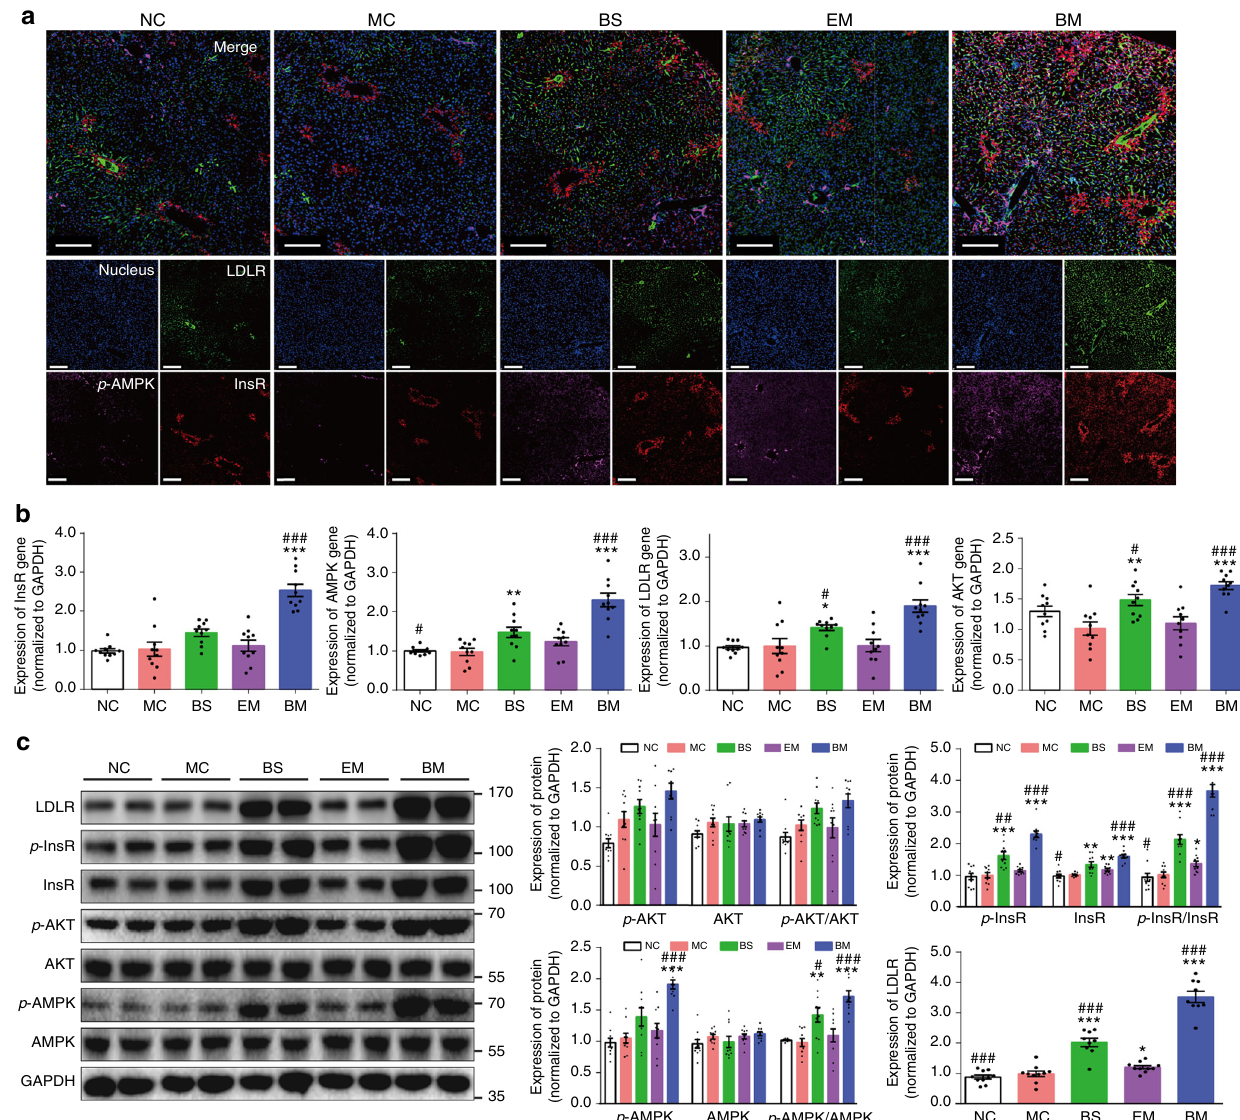
Fig. 5 In vivo pharmacodynamics. C57BL/6J mice were feed with HFD for 8 weeks, followed with randomly allocated into four groups: model control group (MC), BBR-S group (BS, 50 mg kg − 1 of BBR), empty micelle group (EM, same as BBR micelles) or BBR-CTA-Mic group (BM, 50 mg kg − 1 of BBR), accompanied with HFD for another 8 weeks by gavage. Untreated mice fed with standard rodent diet (NC) were used as control. a Representative photographs of p -AMPK (pink), InsR (red) and LDLR (green) protein expression in liver tissue of different group mice were visualized using C2t Nikon fl uorescent microscope (Morrell, USA) by probing with anti-InsR, LDLR and p -AMPK antibodies simultaneously. b The mRNA expression of AMPK , InsR , AKT , and LDLR genes was evaluated by RT-PCR. The results were normalized to GAPDH. c The protein expression of AMPK, p -AMPK, InsR, p -InsR, AKT, p - AKT, and LDLR was tested using western blot analysis. The results were normalized to GAPDH as density ratio. Data are presented as mean ± SEM ( n